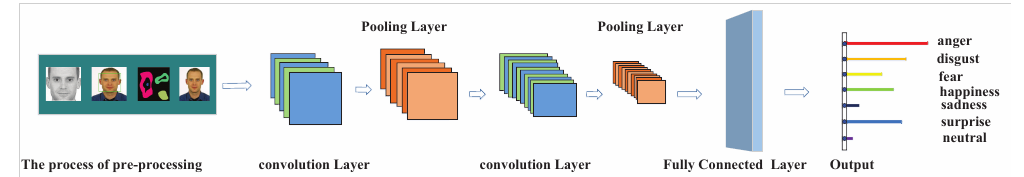
Figure 1. The general structure of a convolutional neural